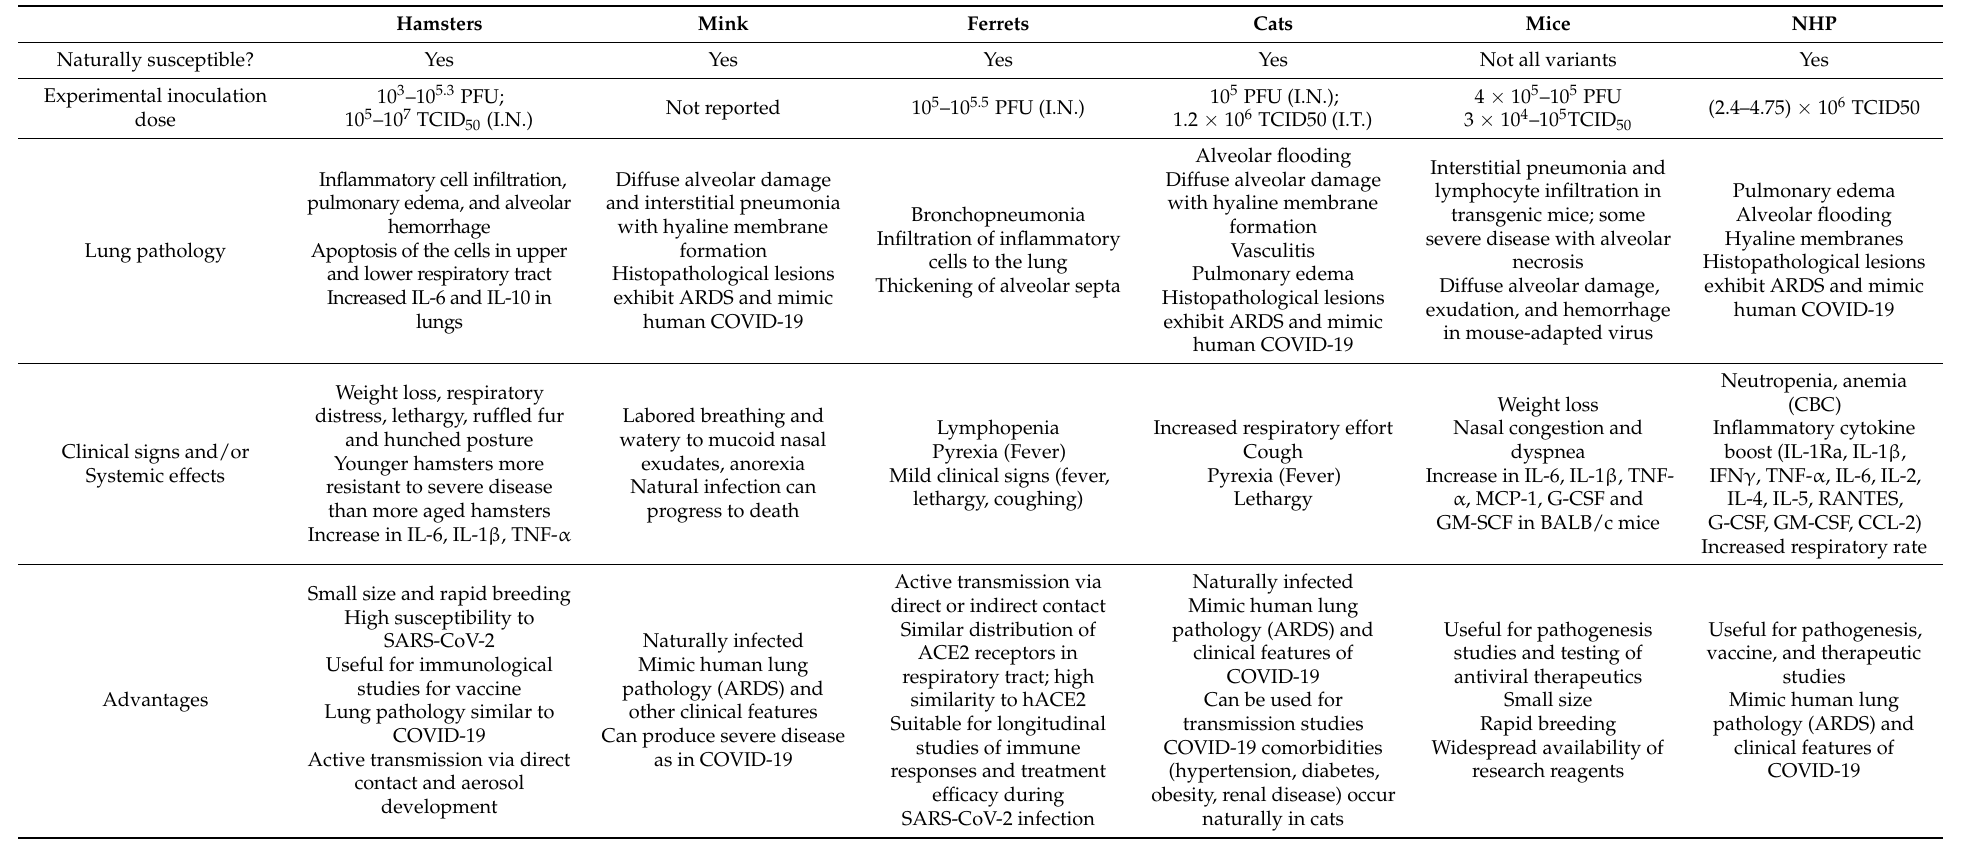
Table 1. Summary of current SARS-CoV-2 animal